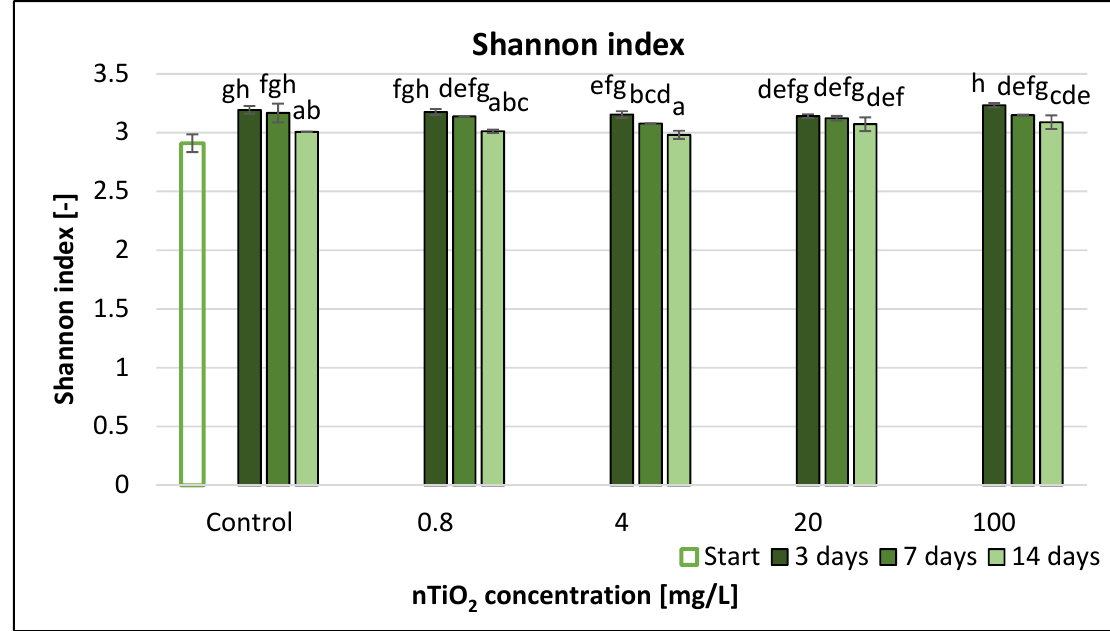
Figure 12. The effect of TiO 2 nanoparticles on freshwater Shannon index value. Letters on the columns indicate significant differences (level of significance: p < 0.05).